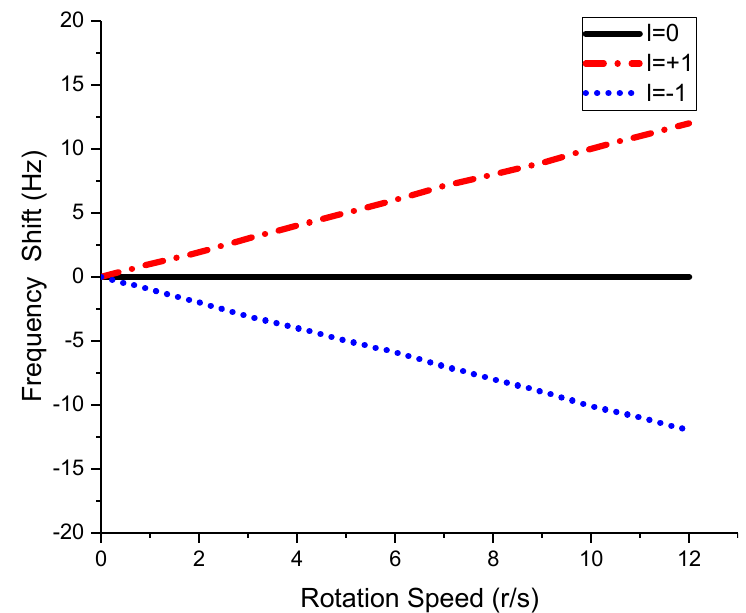
Figure 7. The rotational Doppler frequency shifts of different OAM echoes versus the rotation speed.